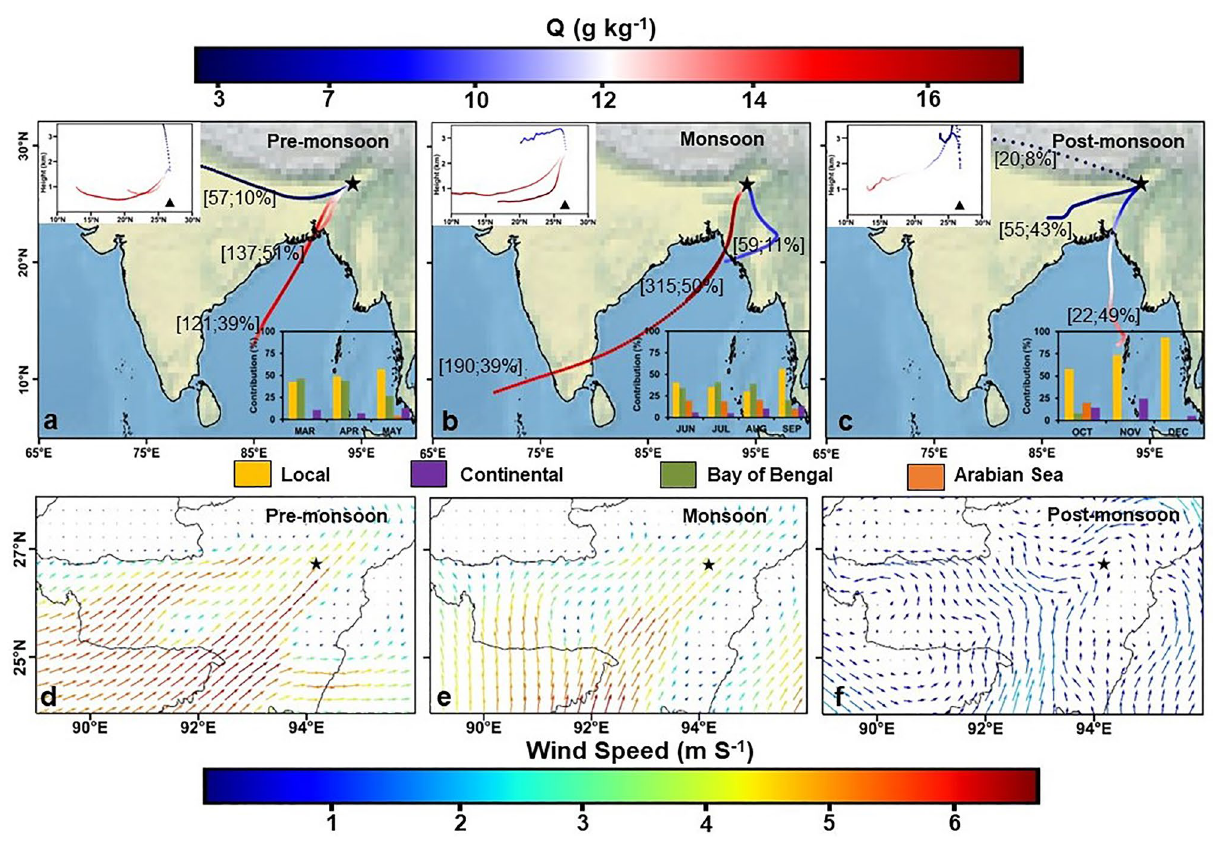
Figure 4. HYSPLIT moisture source allocation. ( a – c ) HYSPLIT clustered 120-h backward wind trajectories. The colormap at the top signifies specific humidity and moisture carried by the clustered mean trajectory. The numbers in bracket signify the frequency of trajectories in a cluster as well as the percentage of moisture transported along the respective clustered trajectory. The inset at top left represents the same plot but for height vs latitude variations. This highlights the role of Shillong Plateau as an orographic barrier in blocking oceanic winds. The inset at bottom right indicates monthly variation in moisture source contribution. ( d – f ) The monthly climatological wind maps derived at 850 hPa during 1979–2018. The wind maps indicate changing wind direction and strength during each falling raindrop due to high temperature and low rainfall 36 . The same can also be inferred from the lower value of LMWL (Local Meteoric Water Line) slope (6.96) for March, when compared to the GMWL (Global Meteoric Water Line) 37 . Towards the end of the pre-monsoon season, a systematic slight depletion in both δ 18 O and dexcess is observed. This can be ascribed to the small influx of isotopically depleted BOB moisture 25,38 circumventing the Shillong plateau, as seen from the wind patterns as well (Fig. 4d). Indian summer monsoon. North-east India receives maximum (~ 1500 mm) rainfall during the ISM sea- son (Jun-Sep). ISM is set about with the northward migration of the ITCZ (Intertropical Convergence Zone), thus driving a huge influx of oceanic [BOB and AS (Arabian Sea)] moisture inland. Unlike Pre-monsoon, the regional hydro-meteorology to the north and south of the Shillong Plateau are analogous (Fig. 2b,d,f,h). The huge influx of oceanic moisture drives a sharp increasing trend of available surface water both to the north and south of the Plateau. This in turn results in lowering the BLH (Boundary Layer Height, Supplementary Fig. 1) and CIN (Convective Inhibition) and increase in ET, CAPE, and Q values (Fig. 2b,d,f,h). Breitenbach et al. 25 and Laskar et al. 34 have reported an overall decreasing trend in δ 18 O at Mawlong and Hailakandi respectively, located immediately south of the Shillong Plateau. A similar trend is reported by Tanoue et al. 35 at three locations in Bangladesh (Dhaka, Sylhet, Chittagong), which is further corroborated with GNIP data from Dhaka and Sylhet. We also observe a similar depleting trend at Jorhat in the first half of monsoon (June-July). Within the depleting trend, a baseline shift in δ 18 O can be observed in mid of June coinciding with the onset of the ISM, which is marked by a depletion in δ 18 O by ~ 4–5 ‰ (Fig. 3a) as well as an increase in the GRACE TWSA values. Following this baseline shift, there is a continuous trend of depletion in both δ 18 O and d-excess. This can be accounted for by the huge influx of oceanic moisture driven by northward migration of organized convection 35 , carrying isotopically depleted δ 18 O and lower d-excess. The oceanic contribution in precipitation estimated using HYSPLIT for June-July is ~ 57%. Even with the ISM and huge oceanic influx, the locally recycled contribution is significant (~ 37%). This is because unlike Pre-monsoon, the moisture laden winds brought by the oceanic influx approach the Shillong Plateau almost perpendicularly (Fig. 4b,e). This serves to